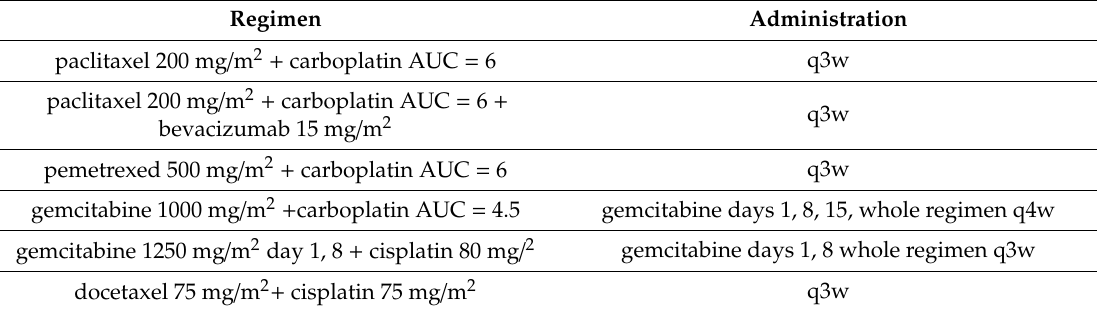
Table 1. Regimens used for the studied population.